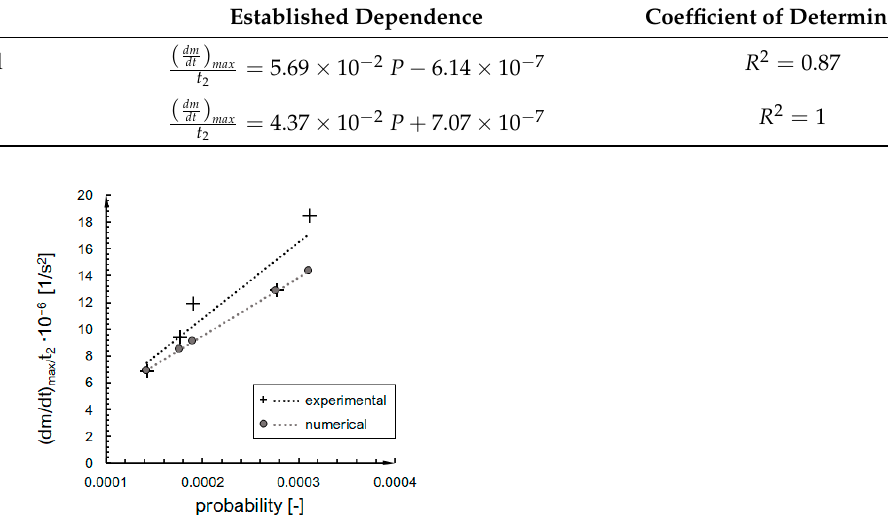
Table 3. Dependences of (b) numerical approach.